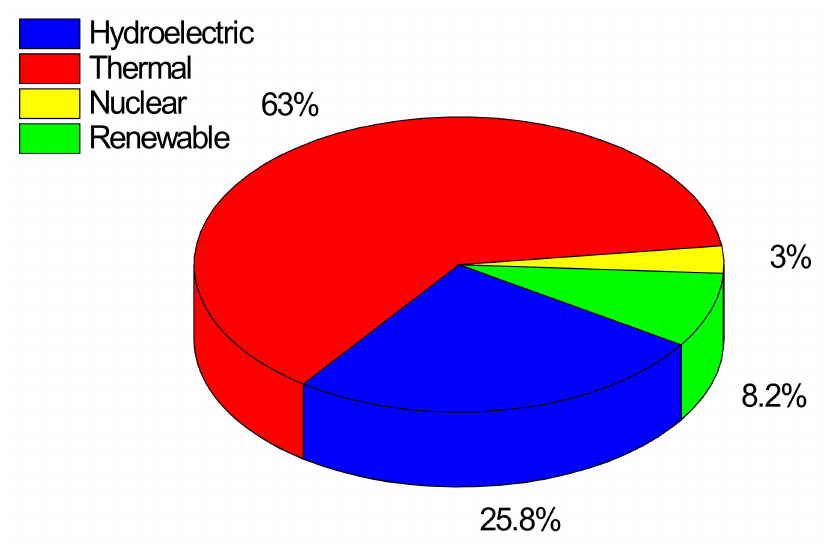
Figure 2. Energy production by different sources in Pakistan in 2018–2019